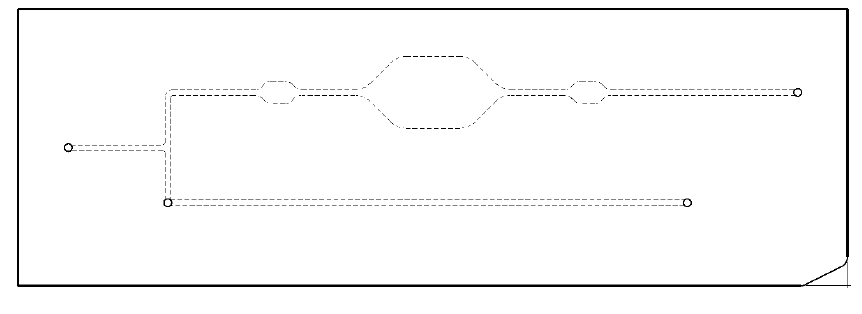
Figure 1. Injected